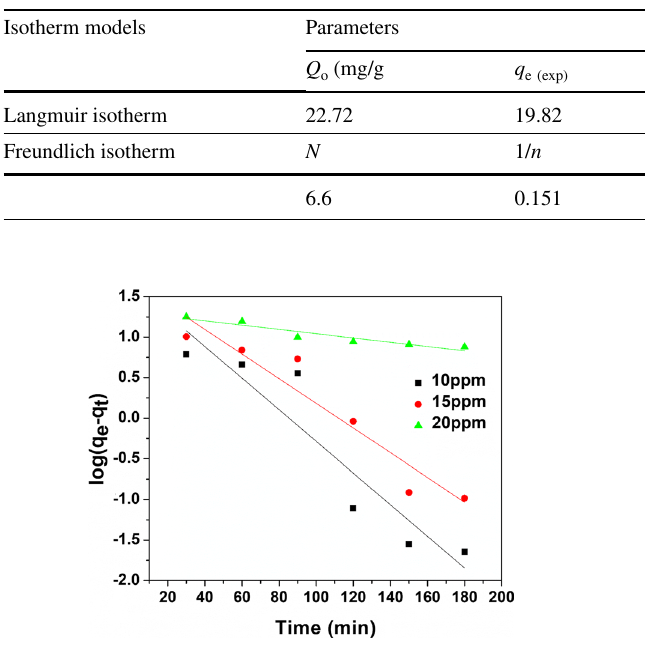
Fig. 11 Pseudo-first-order kinetic curve of Cr(VI) adsorption onto CTAB–kaolin